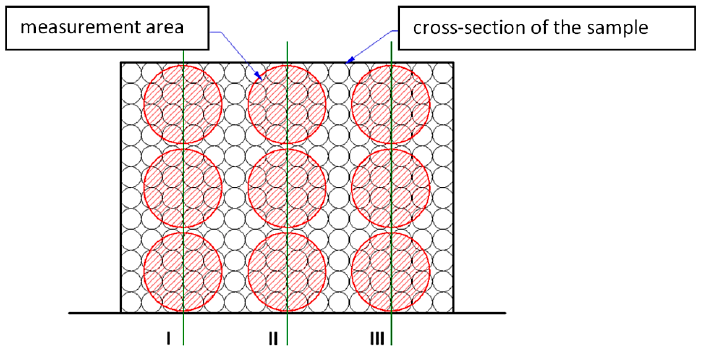
Figure 11. Distribution of the studied nine areas on the sample cross-section. Table 2. Summary of microstructure surface measurements of CFRP.